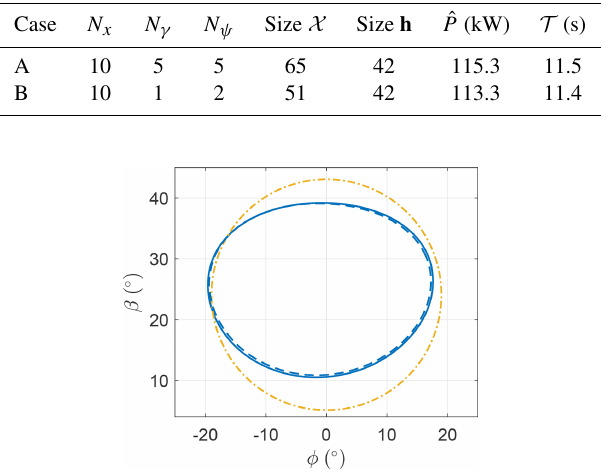
Figure 32. Optimal trajectory for case A ( − ), case B ( − − ) and a circle with radius (cid:56) ( − . ).